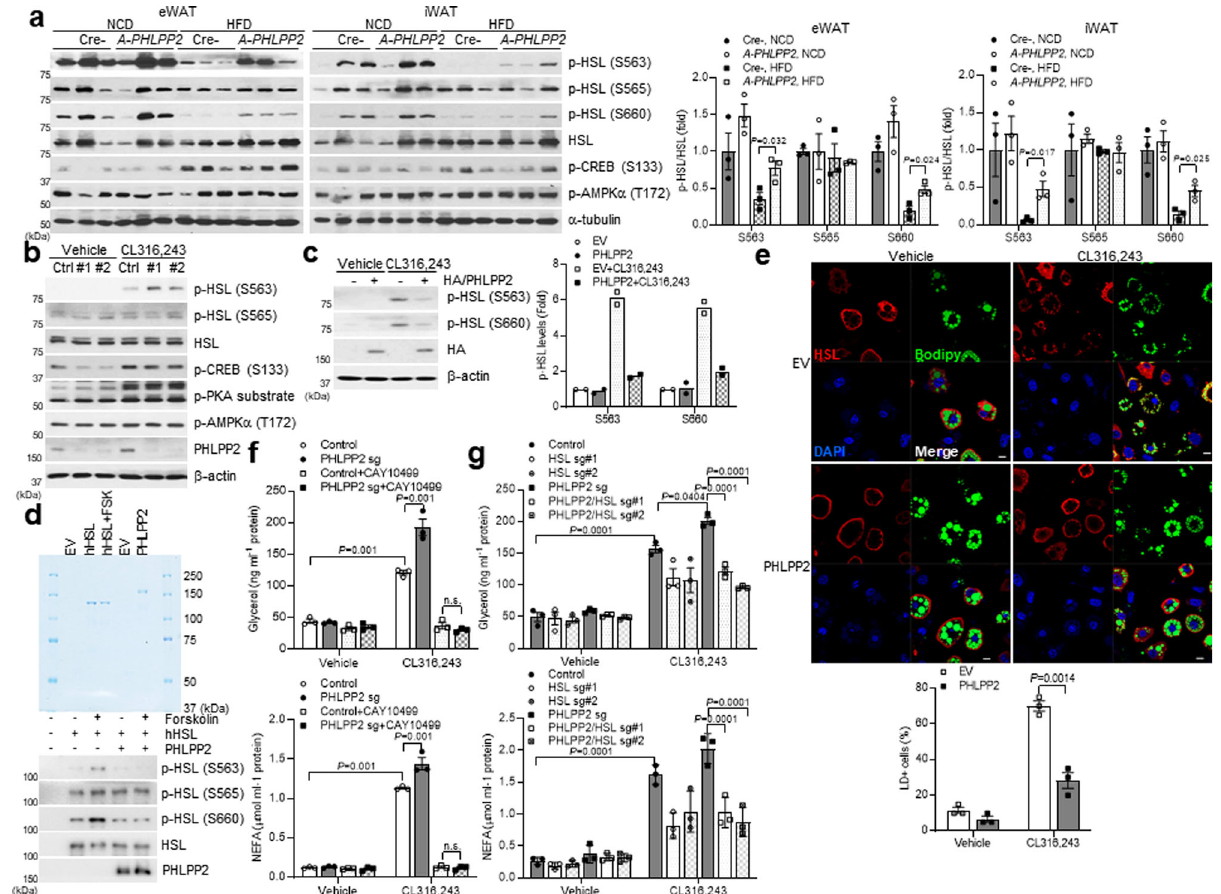
Fig. 4 Adipocyte PHLPP2 regulates HSL phosphorylation and localization. a Western blots in lysates from eWAT (top) or iWAT (bottom) from Cre- or A- PHLPP2 mice fed on NCD or HFD, with quanti fi cation of various HSL phosphorylation sites (right) ( n = 3 independent mice per group). b, c Western blots in lysates from differentiated PHLPP2-repressed 3T3-L1 adipocytes ( b ), or 3T3-L1 adipocytes expressing HA-tagged PHLPP2 ( c ) with quanti fi cation of p-HSL levels (right), with or without CL316,243 ( n = 2 independent experiments). d Coomassie brilliant blue staining of puri fi ed human HSL (hHSL) or PHLPP2 with or without 10 μ M forskolin (FSK) (top), for phosphatase assay of HSL Ser563 and Ser660 with puri fi ed PHLPP2 (bottom) ( n = 2 independent experiments). e Immuno fl uorescence of HSL (red), Bodipy (green), and DAPI (blue) in 3T3-L1 adipocytes expressing control or HA-tagged PHLPP2 with or without CL316,243 (top). Quanti fi cation of HSL localization on lipid droplets was performed by directly counting Bodipy-positive cells from images of randomly chosen fi elds (bottom) ( n = 3 independent samples). Scale bars, 10 μ m. f , g In vitro lipolysis in differentiated control or PHLPP2-repressed adipocytes with or without CL316,243 and/or CAY10499 ( f ) or HSL deletion ( g ) ( n = 3 independent mice per group). All data are shown as the means±SEM. Statistical signi fi cance was determined by unpaired two-tailed Student ’ s t -test for a, e , and two-way ANOVA with Tukey ’ s multiple comparison test for f , g . n.s. not signi fi cant ( P